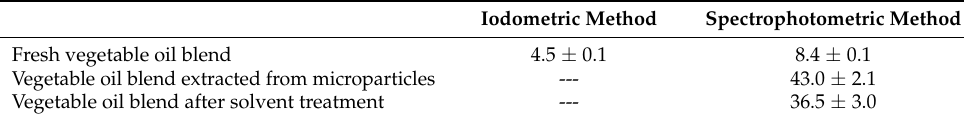
Table 2. Peroxide values ± sd of the vegetable oil blend as it is and from